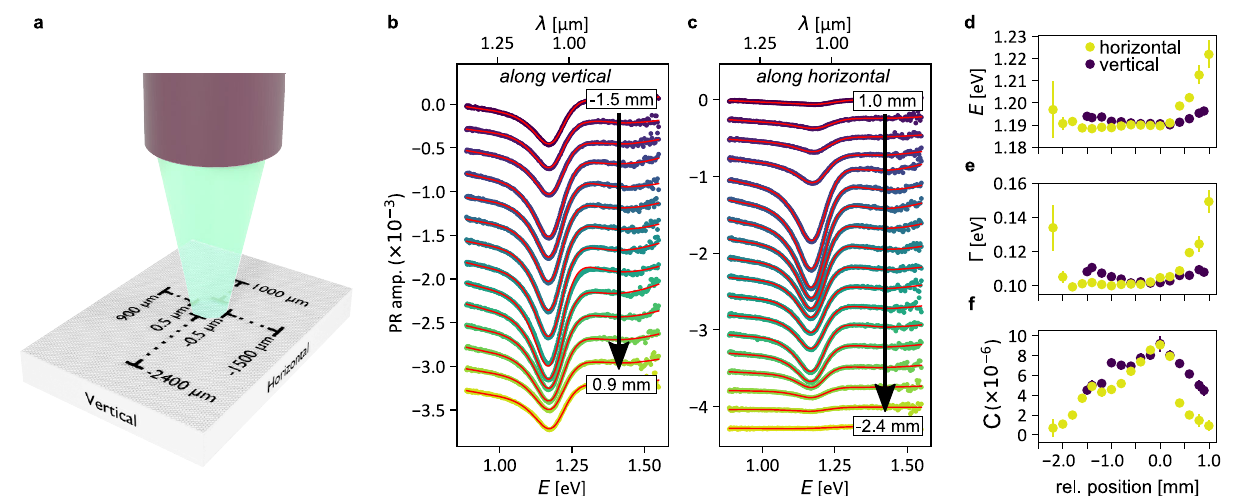
Fig. 3 | Spatial modulation of the optical response of Bi/SiC. a Sketch of the scanning movementalong averticaland horizontalline on Bi/SiC. b , c Evolutionof the PR resonance of the A -peak along the vertical and horizontal scanning line, respectively. Solid red lines represent the fi tting curves (Eq. (1)). d – f The energy of the A exciton transition, broadening, and the PR amplitude, respectively. (Pulsed